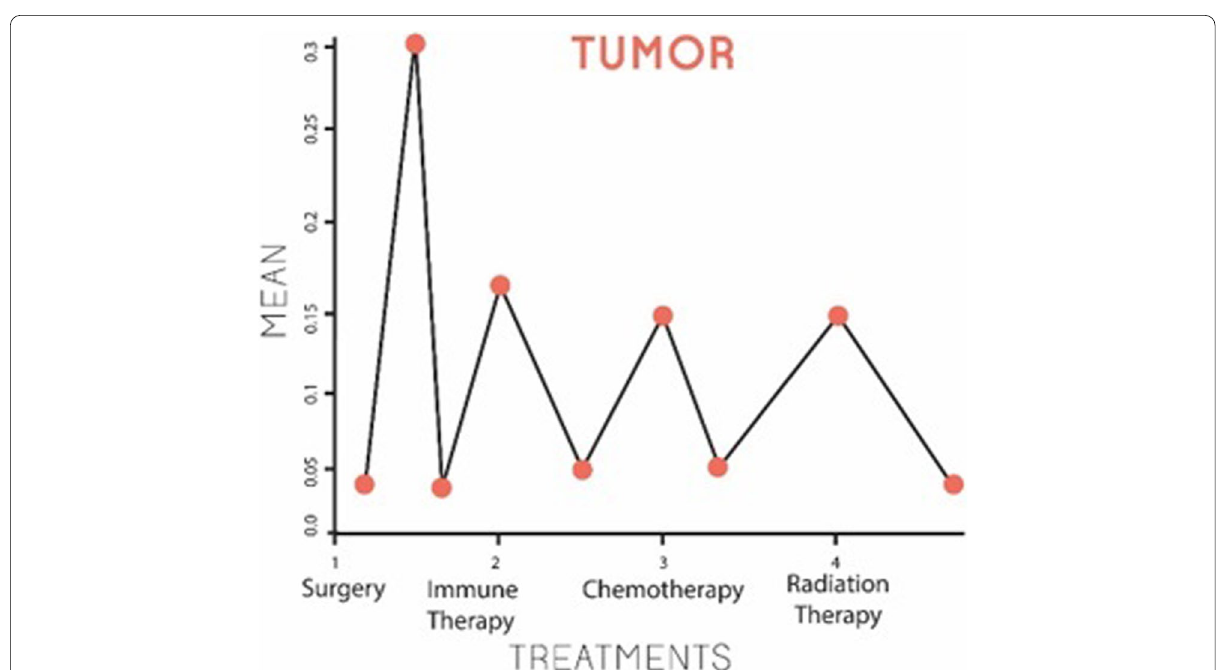
Fig. 7 Treatment accuracy for